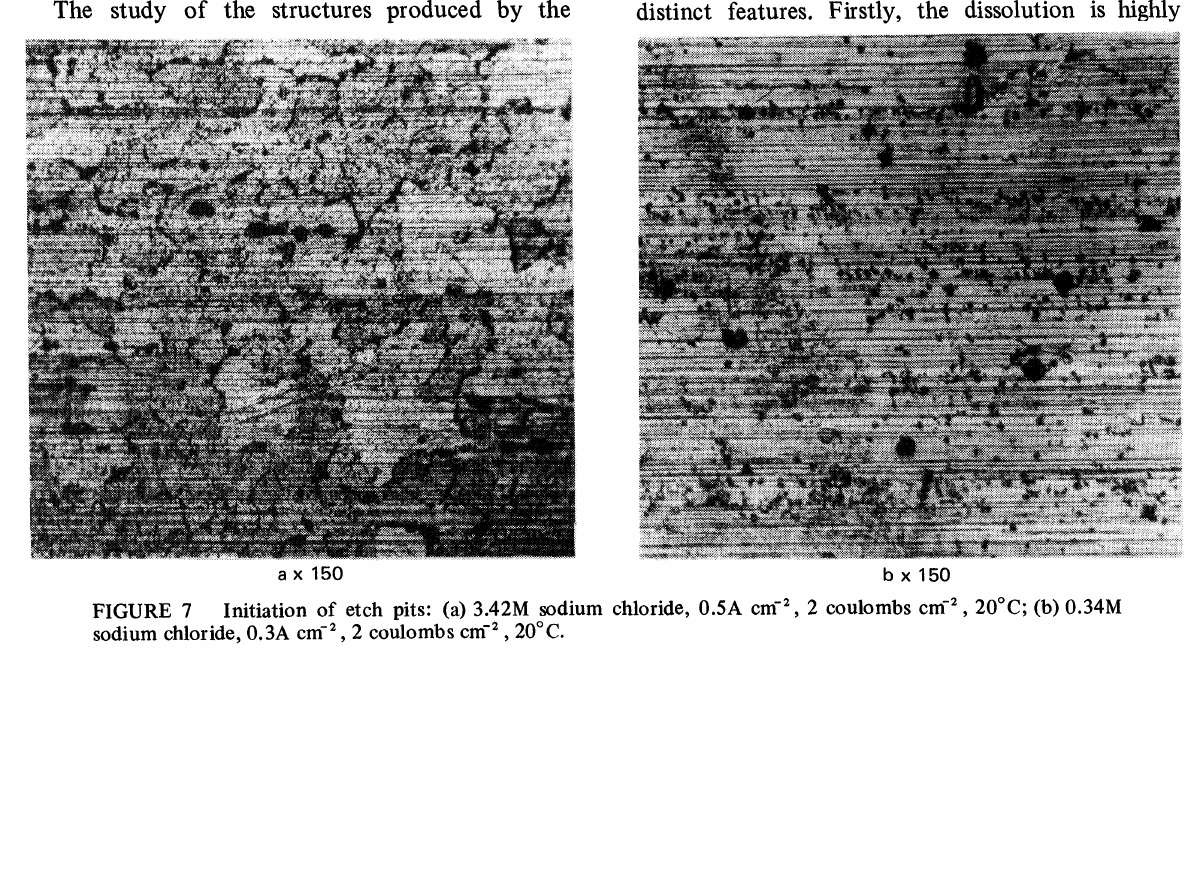
- in 3.42M sodium